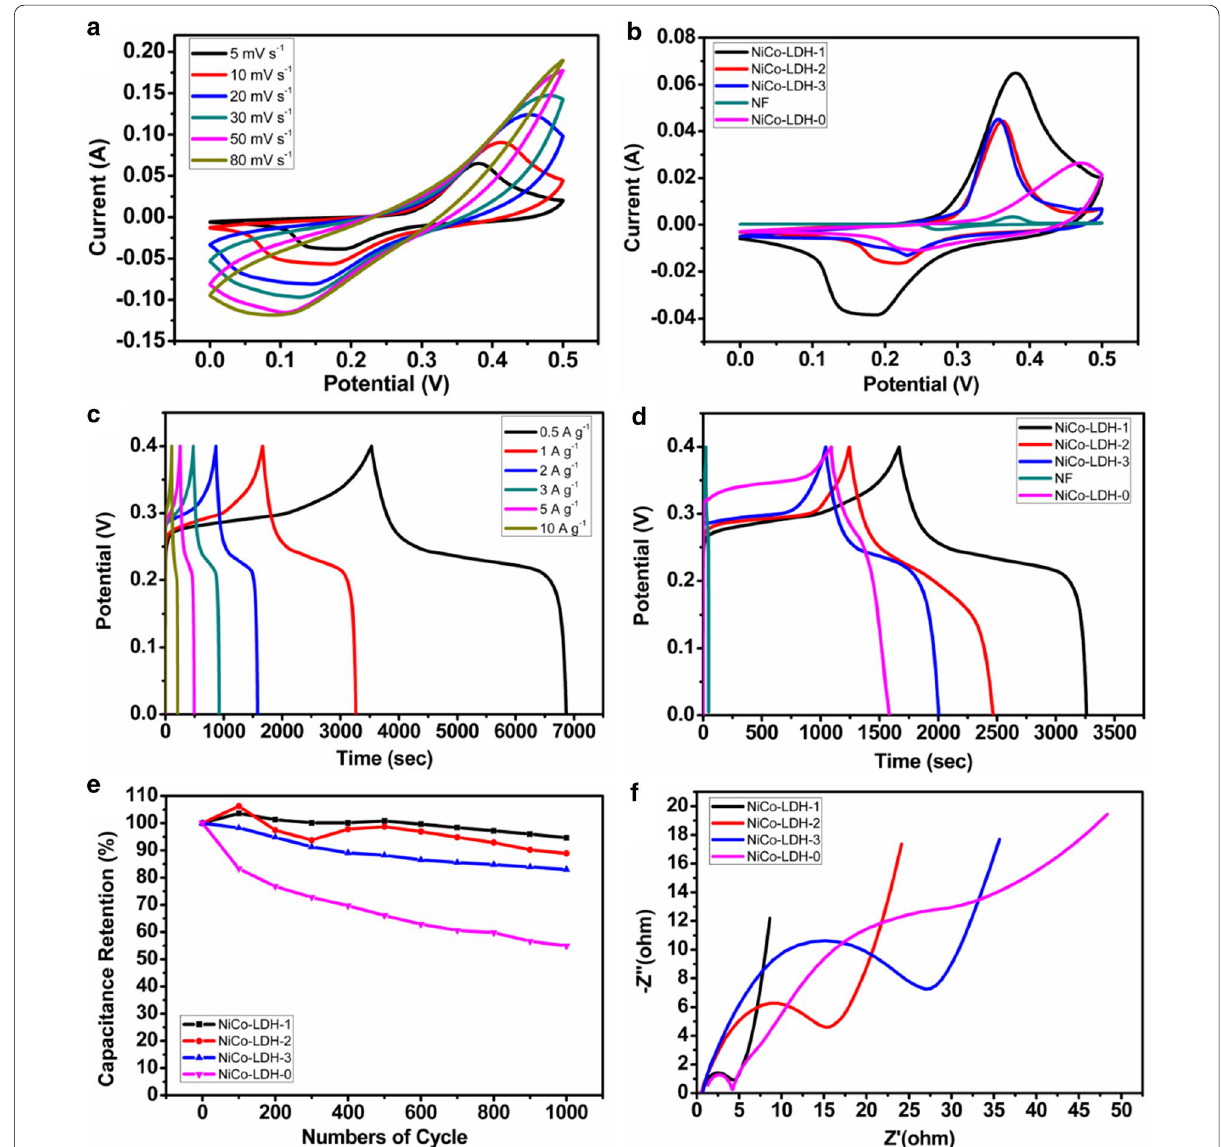
Fig. 5 a CV curves of NiCo-LDH-1 at different scan rates; b CV curves of samples at scan rate of 5 mV s − 1 ; c GCD curves of NiCo-LDH-1 at different current densities; d GCD curves of samples at 1 A g − 1 ; e cyclic stability diagram of NiCo-LDH-1, NiCo-LDH-2, NiCo-LDH-3 and NiCo-LDH-0 at 10 A g − 1 ; f Nyquist plots of NiCo-LDH-1, NiCo-LDH-2, NiCo-LDH-3 and